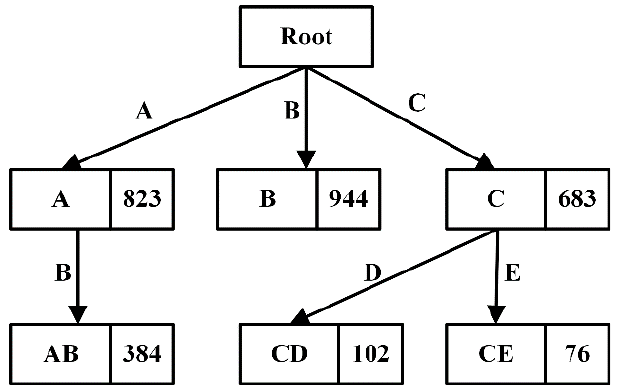
Figure 4. Prefix tree cache